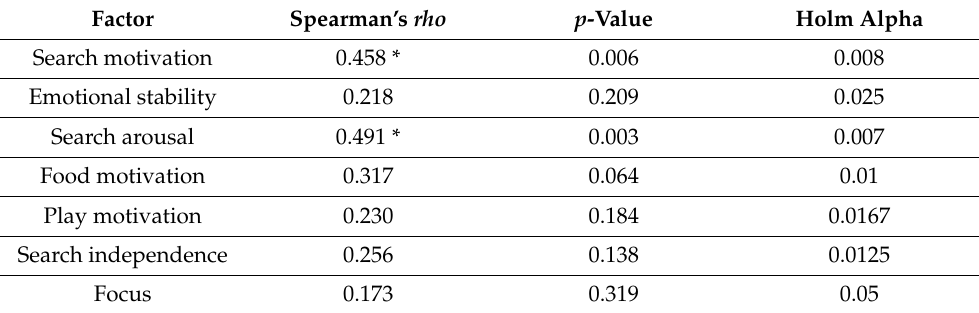
Table 7. Correlations between overall working performance score and work behaviour factors with calculated correlations and significance after Holm–Bonferroni